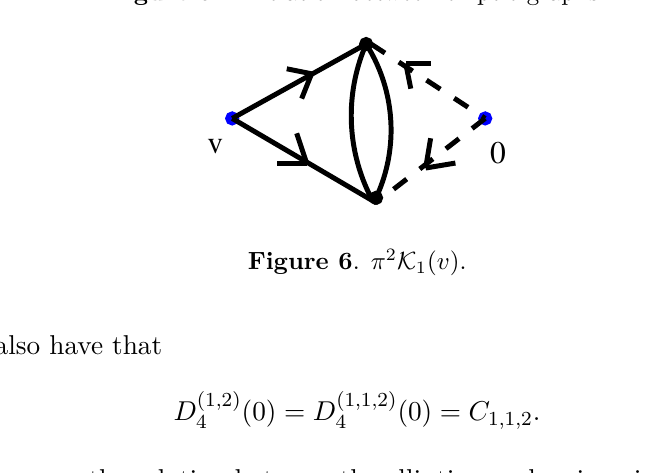
Figure 5 . A relation between elliptic graphs.